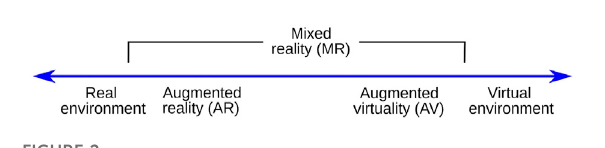
FIGURE 2 Reality – virtuality continuum. Reproduced under CC-BY-4.0, Freeman, R